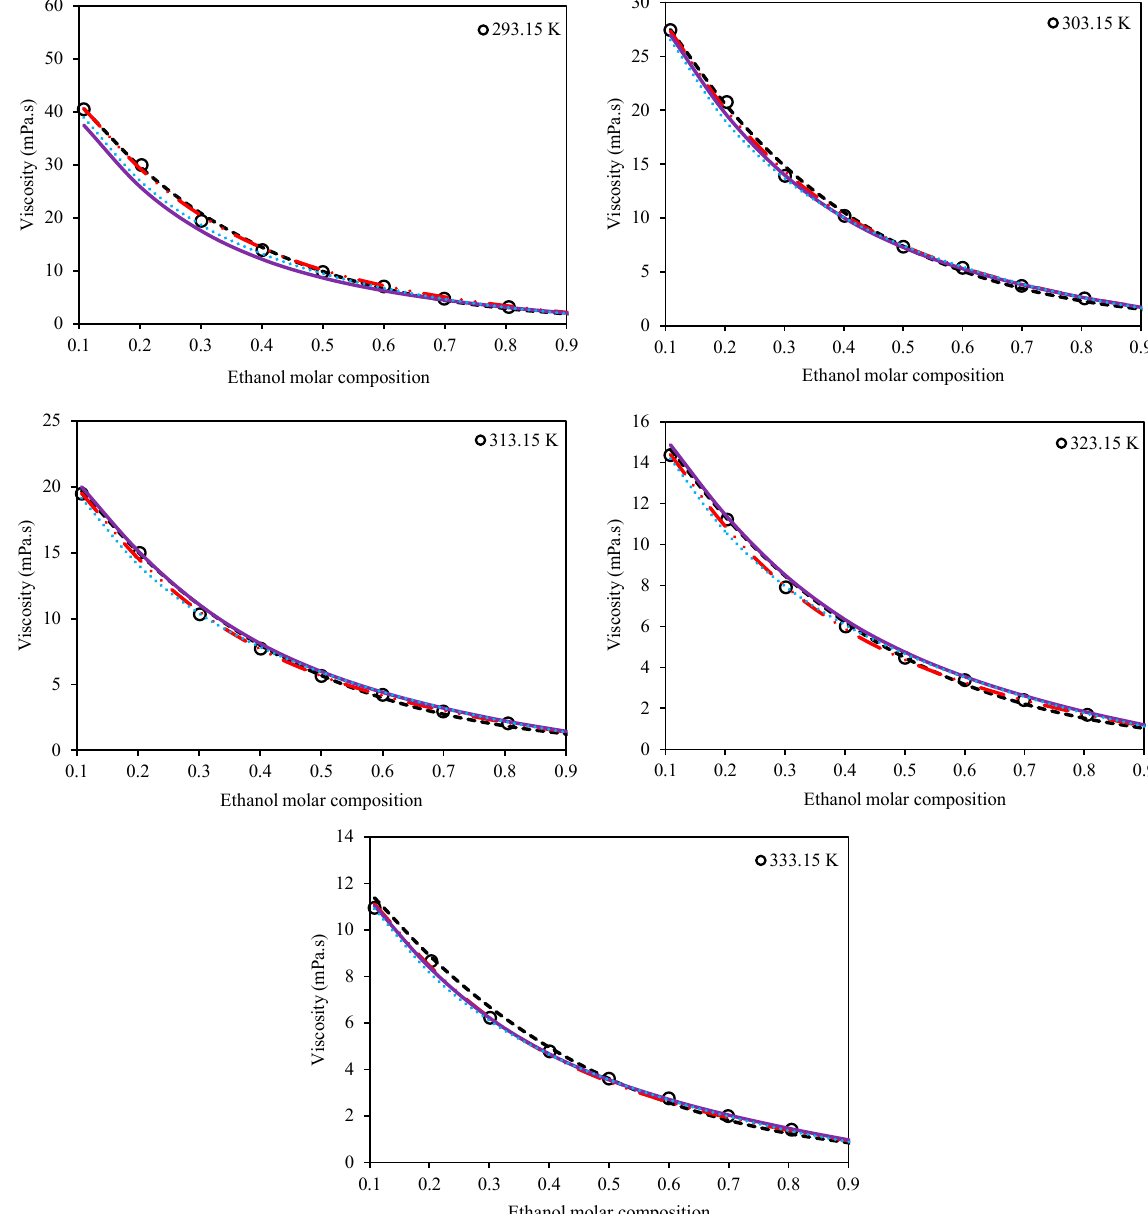
Figure 4. Comparison of the behavior of the Grunberg–Nissan [20], Jouyban–Acree [21], McAllister [22], and Preferential Solvation [23,24] models with respect to the experimental trend for the system of Ethaline (1 ChCl:2 ethylene glycol) + ethanol at various temperatures and at a pressure of 100 kPa. (Grunberg–Nissan ( --- ), Jouyban–Acree ( ― •• ), McAllister ( ― ), Preferential Solvation ( ••• ), Experimental data ( o )).